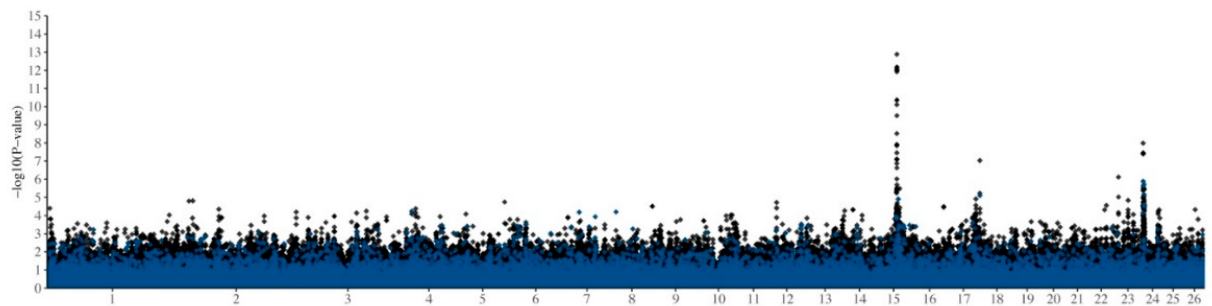
Figure 2. Comparison of imputed HD and 50K genotype data. Efficient Mixed-Model Association eXpedited (EMMAX) analysis of log-transformed serum GGT levels at 21 days after a measured sporidesmin challenge (GGT21), fitting contemporary group and the first two principal components fitted as covariates. Blue diamonds ( ♦ ) show p-values for the ~41k SNPs from the Illumina OvineSNP50 BeadChip. Black diamonds ( ♦ ) show p-values for the additional Ovine Infinium ® HD SNP BeadChip SNPs.